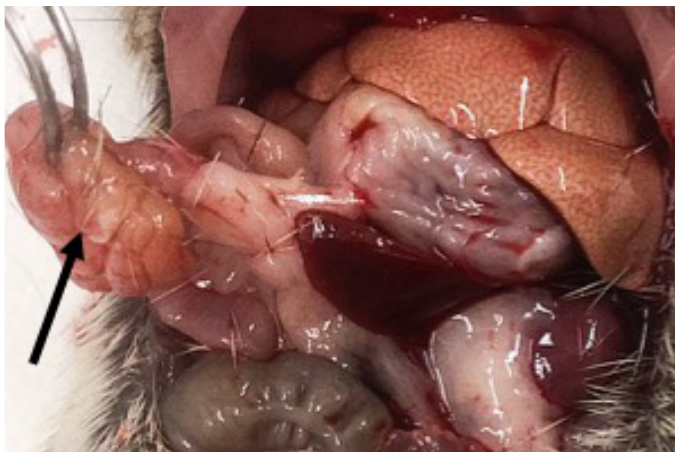
Figure 8. Floater—1 cm fibrous clump of necrotic adipose (in forceps, arrow) is connected to adjacent uninvolved adipose and pancreas by organized connective tissue as evidence of peripancreatic steatitis associated with ‘leaky pancreas syndrome’ occasionally observed in young rats during rapid development of T2DM when they consume a hiCHO , diabetogenic diet from weaning. It suggests a role for hiCHO diet in pancreatitis, as this is seen primarily with diets based on 70:10:20 CHO:Fat:Protein ratio with no fiber.